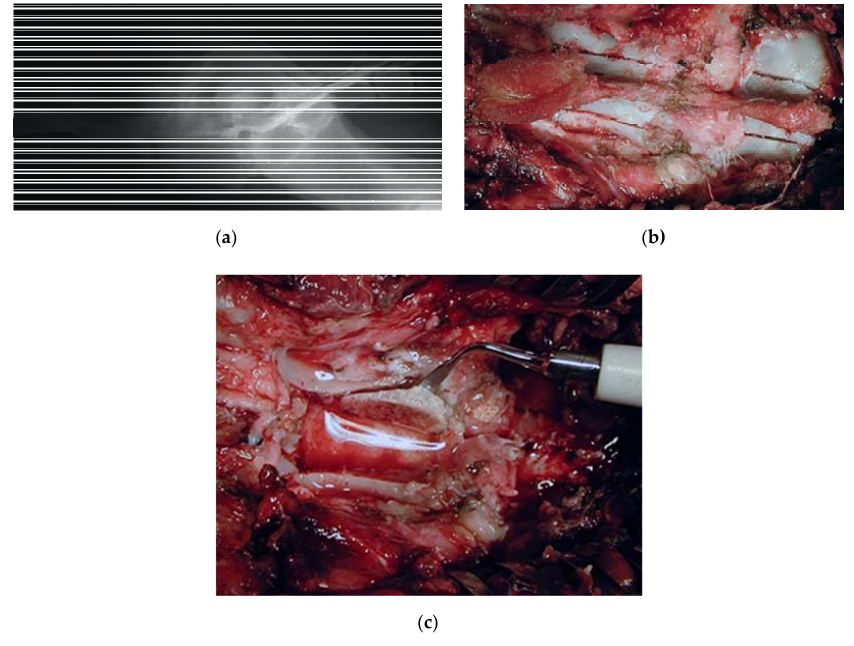
Figure 4. Dog, nine years old, diagnosed with a lumbosacral stenosis. ( a ) Epidurography showing a severe stenosis. ( b ) Skeletonization of the lumbosacral segment. Note the incision of the last lumbar and first sacral vertebra, along with the possibility of a further lateral extension ( c ) lumbar laminectomy. The thickness of the lamina measures 12 mm. Laminectomy was performed by means of the piezoelectric bone scalpel. An angled large saw tip (OT7, Osteotomy Tips Kit, Mectron Medical Technology, Genoa, Italy) was used. The bone preset involved a frequency of 30 KHz and a power of 16 W. A complete sparing of the underlying dura was observed after the osteotomy. OT7 designated tip also allowed to wide laterally the osteotomy in an easy way after and the dura exposure. Note that this tip allows cuts up to 15 mm of